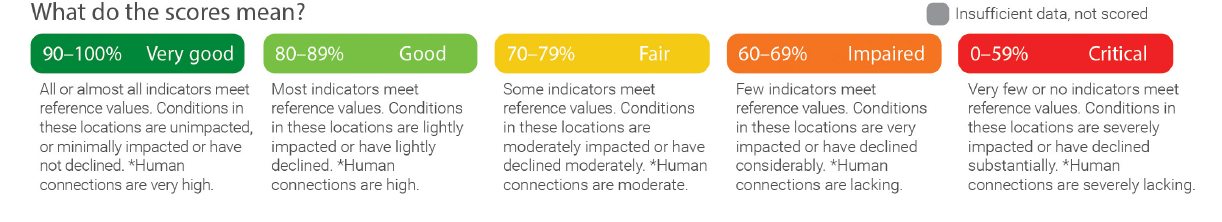
FIGURE 1 | Definitions of the scoring bins used for all status